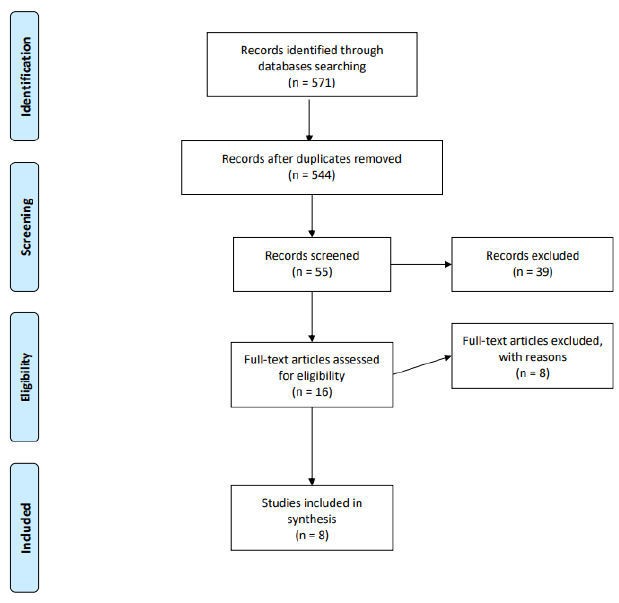
Figure 1. Prisma flow